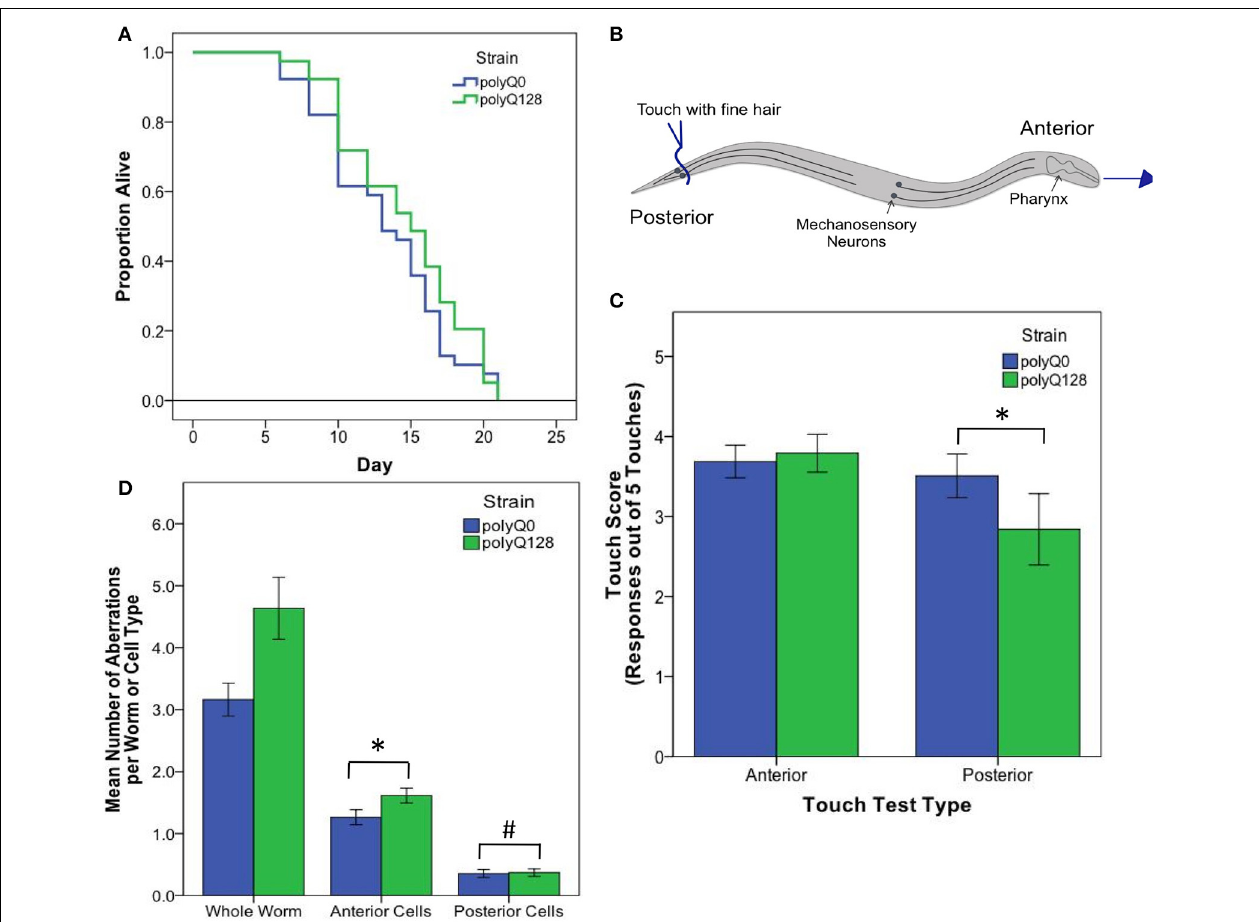
FIGURE 2 | PolyQ0 and polyQ128 exhibit basal differences in mechanosensory neuron morphology and function without altered lifespan. (A) Kaplan–Meier survival curves for one representative survival experiment shown for empty vector (L4440) treated polyQ0 and polyQ128 animals. Mean and median lifespan do not differ between the two strains. (B) Schematic of posterior touch test; an animal is touched at the tail and normally moves forward, gaining 1 positive response to touch (out of 5). For anterior touch test, animals are touched at the head and scored for backwards movement. Mechanosensory neurons (PLMs and ALMs) and pharynx shown. (C) Anterior and posterior touch test scores for empty vector control